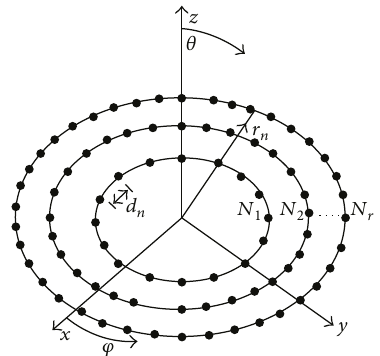
Figure 1: The con fi guration of the